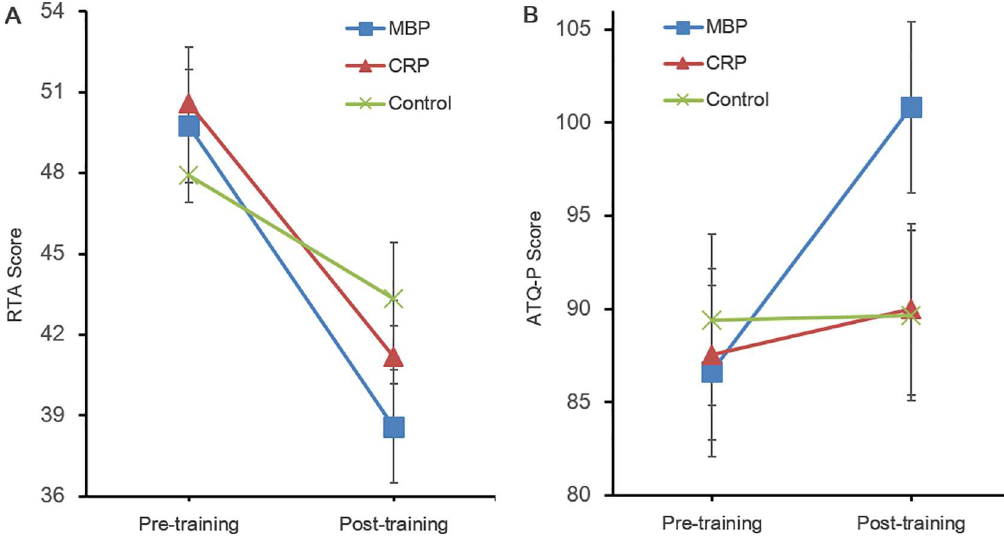
Fig 2. Changes of the RTA and ATQ-P among groups between pre- and post- training. MBP = Mindful Breathing Practice; CRP = CognitiveReappraisal Practice; RTA = Revised Test Anxiety scale; ATQ-P = Automatic Thoughts Questionnaire-Positive